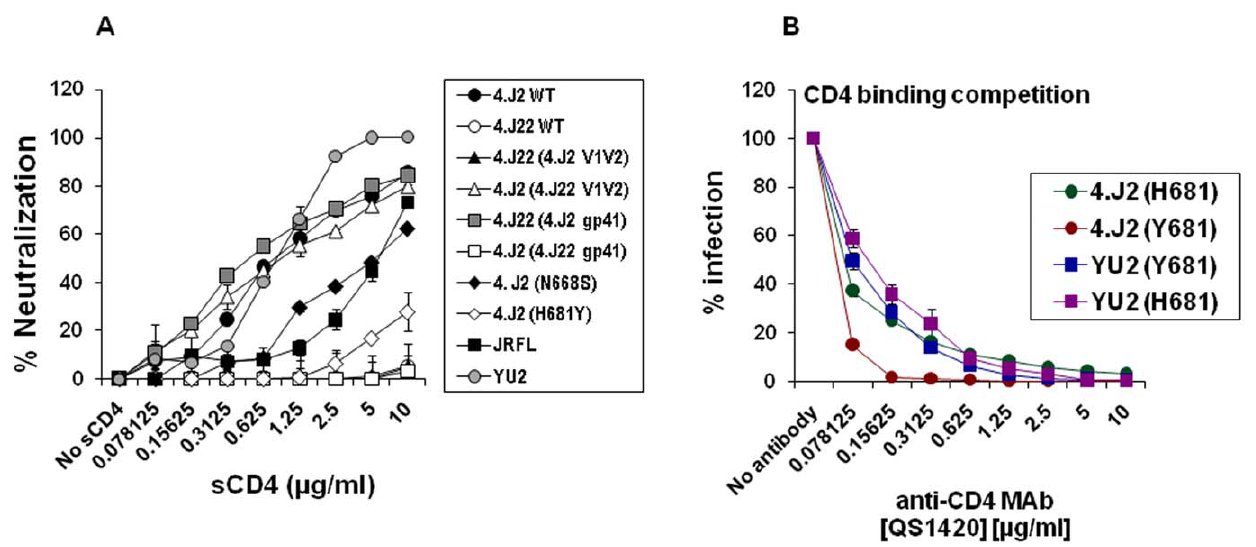
Figure 4. Effect of presence of H681 on gp120-CD4 interaction. A. Neutralization sensitivity of Env-pseudotyped viruses to sCD4 was carried out in TZM-bl cells. Percent neutralization was measured by scoring RLU as indicated on Y-axis at various concentrations of sCD4 plotted on X-axis. B. Competition between Env-pseudotyped viruses (carrying H681 and Y681) and anti-CD4 MAb QS1420 for binding to cellular CD4. Env pseudotyped virus was expected to compete with QS1420 to bind with the cellular CD4 on TZM-bl cells for productive infection. Percent infection of Env pseudotyped virus on Y-axis in presence of various concentration of QS1420 on X-axis was recorded in comparison with infectivity of virus in absence of QS1420 which was considered as 100%. Percent infectivity was assessed by measuring RLU in a luminometer. The result in the graph is representative of a single experiment performed in duplicate. The assay was performed at three independent time points using an independent virus preparation.